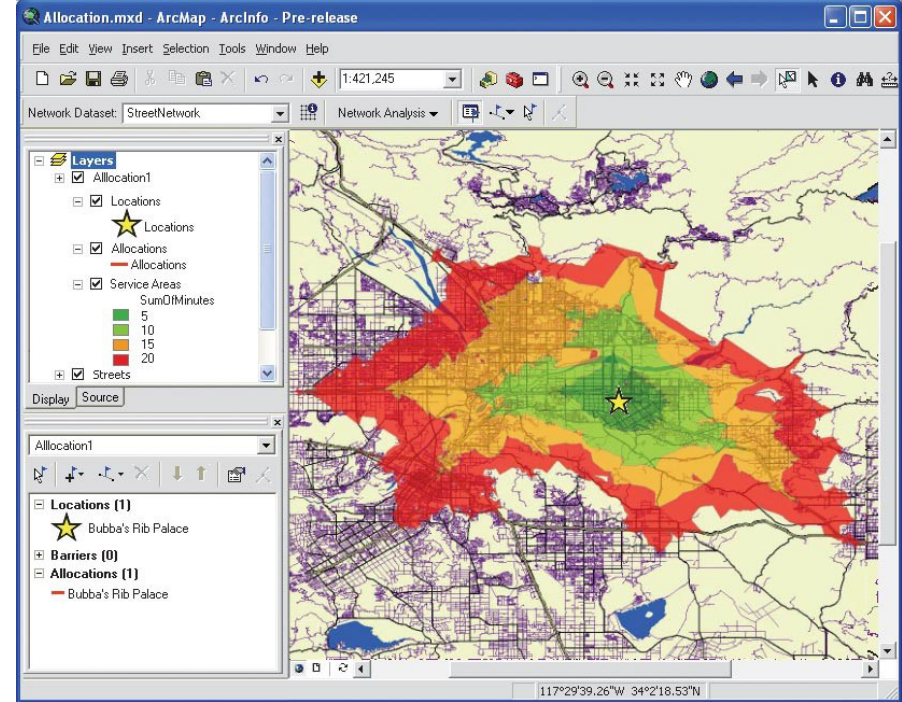
Figure 2. Determination of a service area around a selected base point, including polygons denoting different levels of accessibility [30].